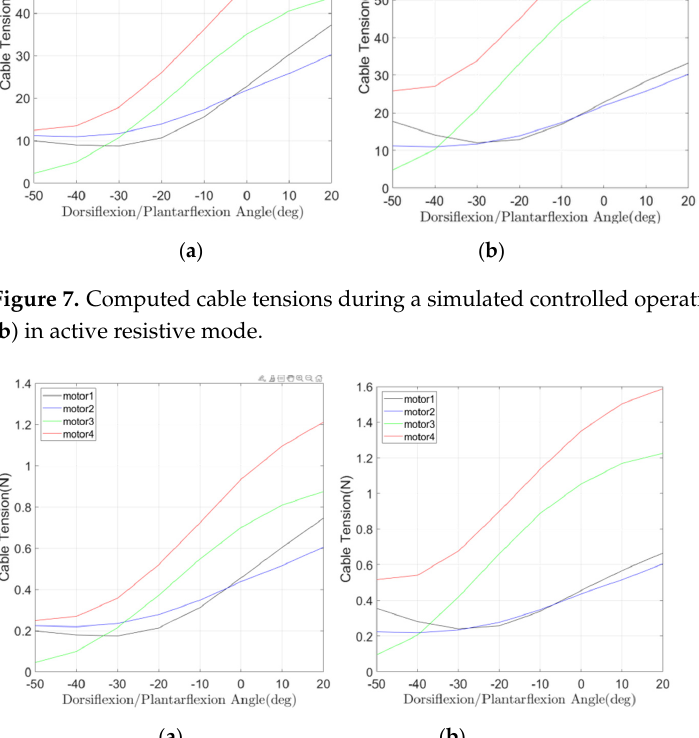
Figure 8. Computed motor torques during a simulated controlled operation: ( a ) in passive mode and ( b ) in active resistive mode. ( b ) in active resistive